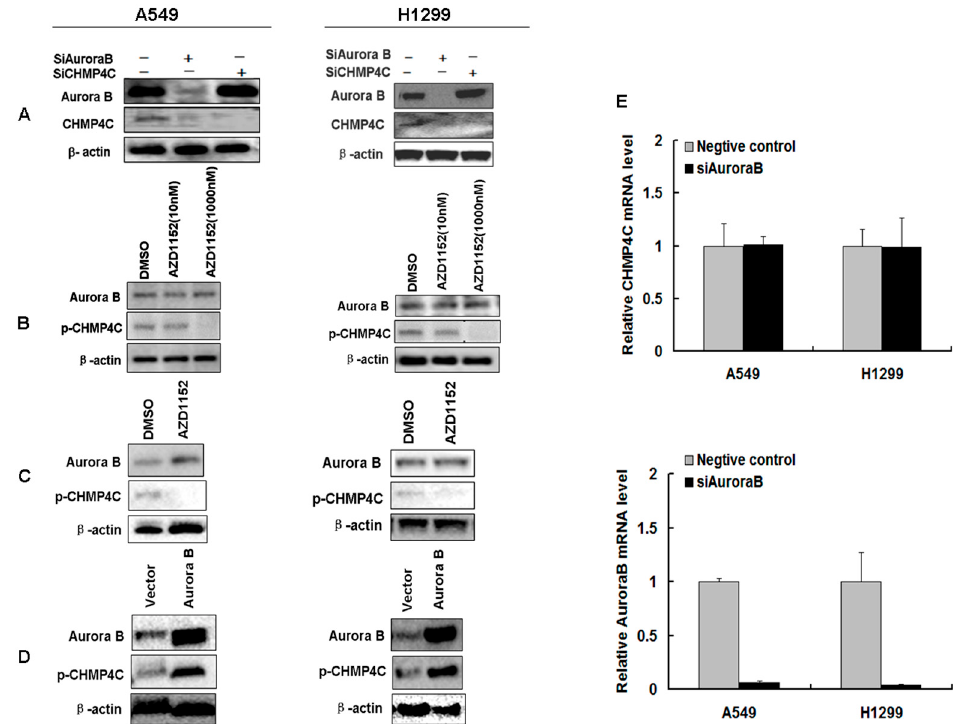
Figure 5. CHMP4C acts downstream of Aurora B. ( A ) Expression of Aurora B and CHMP4C after Aurora B or CHMP4C knockdown in A549 and H1299 cells; ( B ) The phosphorylation level of CHMP4C in untreated and AZD1152 treated (10 and 1000 nM) A549 and H1299 cells; ( C ) The phosphorylation level of CHMP4C in untreated and AZD1152 treated (100 nM) A549 and H1299 cells; ( D ) Western blot analysis of CHMP4C phosphorylation level in A549 and H1299 cells transfected with pCDNA3.1-Aurora B; ( E ) The mRNA expression level of CHMP4C or Aurora B was quantitated with real-time PCR (mean ± S.E., n = 3) after the A549 and H1299 cells undergone transfection of negative control or siAurora B.